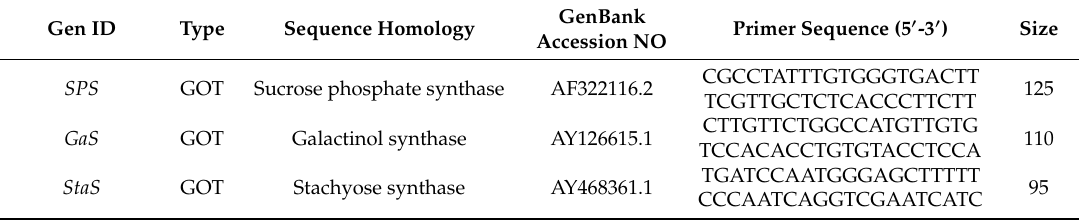
Table 1. Target gene (GOT) and reference gene (Ref) information. The GenBank accession numbers of Medicago sativa expressed sequence tags, used to design PCR primers, are also provided together with PCR primer sequences and amplified fragment